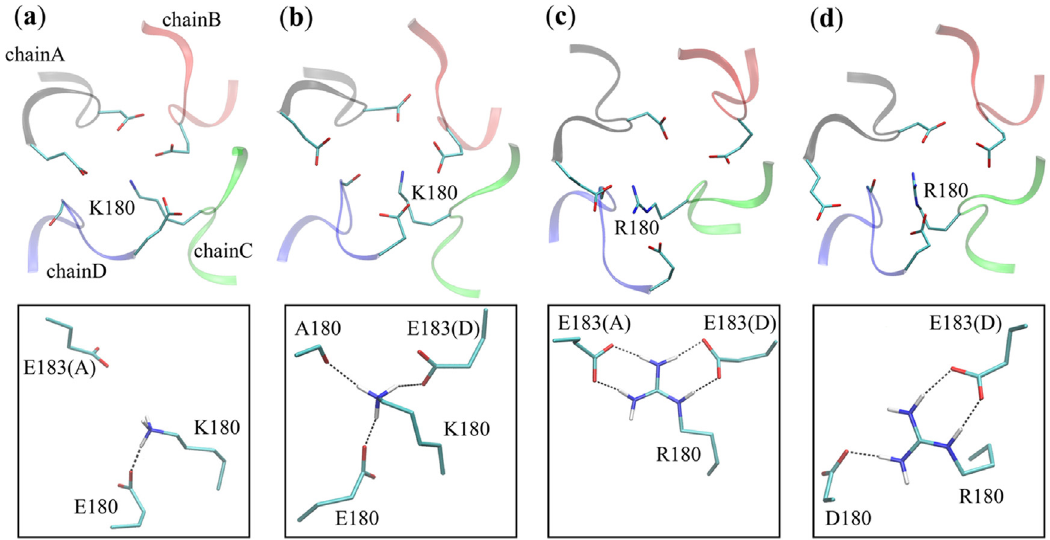
Fig 5. Structural comparison on the hydrogen bonding interactions between the side chains of Lys180/Arg180 and other residues. (a) For the DEKA mutant in the a -system (ID 13 in Table B in S1 File), Lys180 side chain can form only one stable hydrogen bond with Glu180. (b) For the DEKA mutant in the d -system (ID 17 in Table B in S1 File), Lys180 side chain can form concurrent hydrogen bonds with the carboxylate groups of Glu180 and Glu183 in chain D as well as the backbone carbonyl oxygen atom of Ala180. (c) For the DERA mutant in the a -system (ID 15 in Table B in S1 File), Arg180 side chain can form concurrent hydrogen bonds with the carboxylate groups of Glu183 residues in both chain A and chain D. (d) For the DERA mutant in the d -system (ID 19 in Table B in S1 File), Arg180 side chain can form concurrent hydrogen bonds with the carboxylate groups of Asp180 and Glu183 in chain